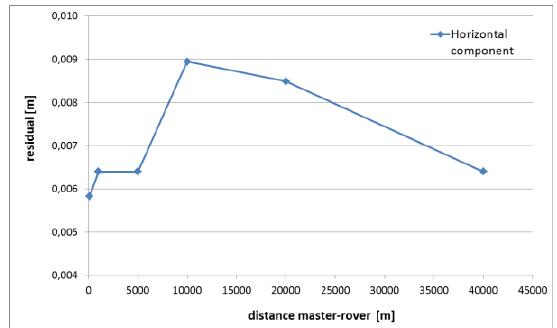
Figure 3. Horizontal residual with respect to the master-virtual station distance.